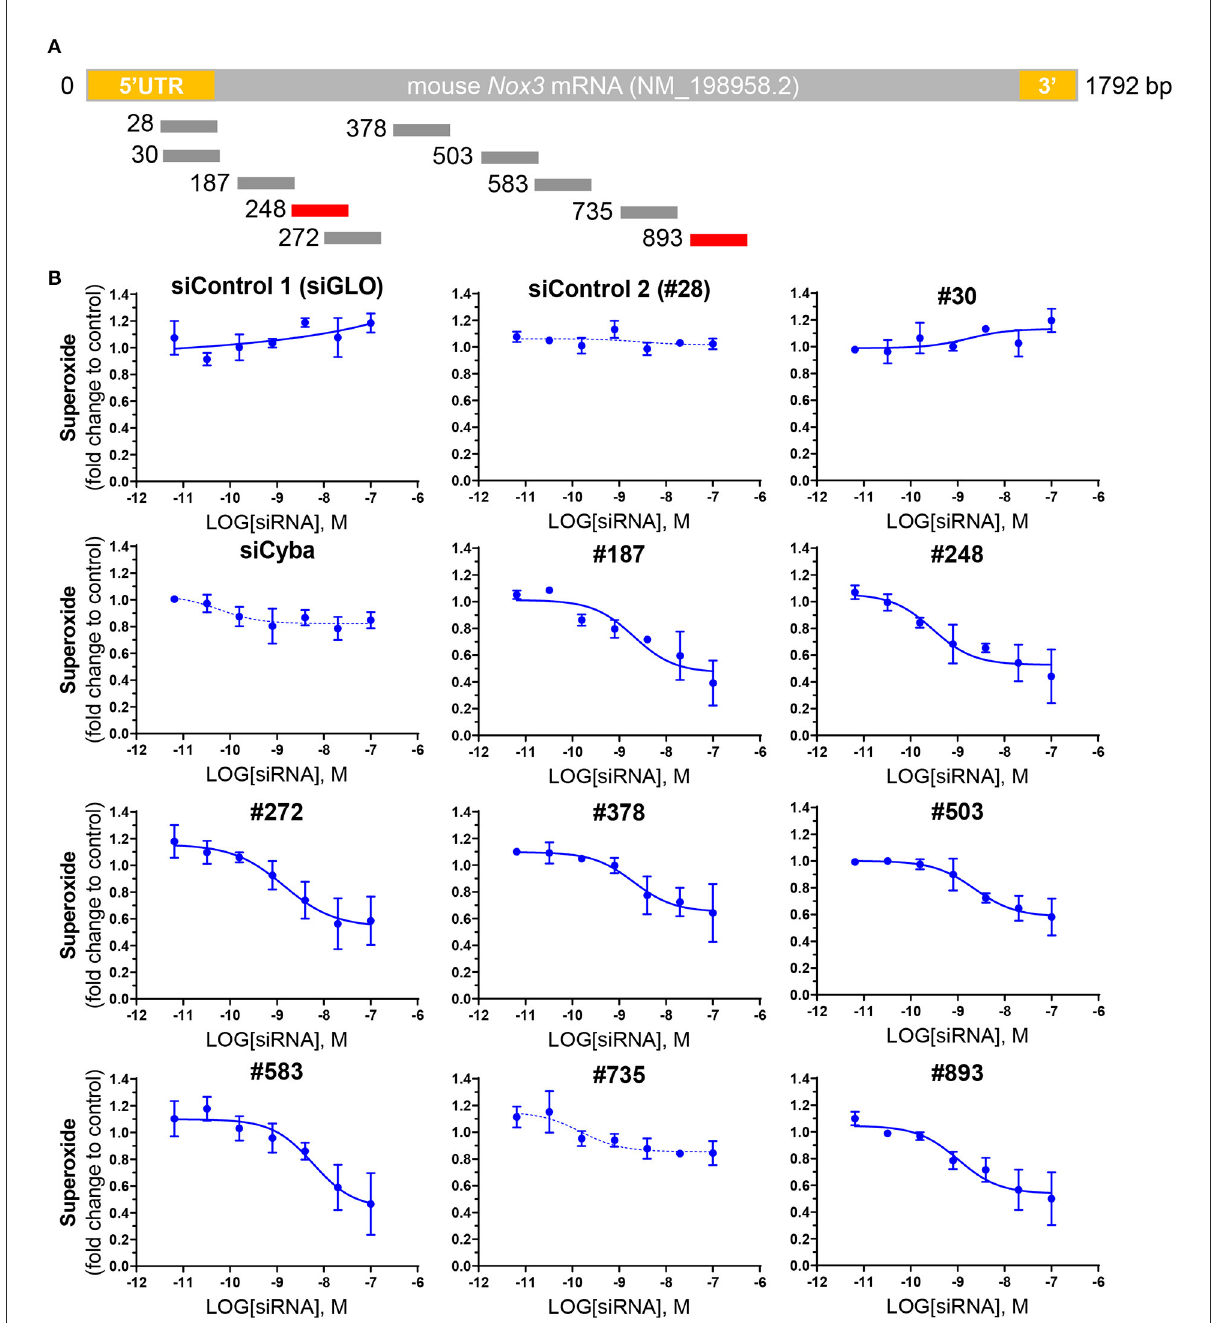
FIGURE2 Screening of NOX3 siRNAs on mouse Nox3 activity in vitro . (A) relative pairing region of the 10 siRNAs targeting the mouse Nox3 mRNA on the mNox3 transcript. (B) ROS production measured by WST-1 in HEK cells expressing the mouse Nox3 complex (Nox3, Cyba, Noxa1, Noxo1; high MOI) transfected with increasing concentrations (0.0064 − 100nM) of the siRNAs of interest and control siRNAs [siGLO and siCyba]. siRNA concentrations are represented as the logarithm of the concentration (M). ROS production was normalized to the ROS values reported before siRNA treatment. Data represent the average of three independent experiment + -